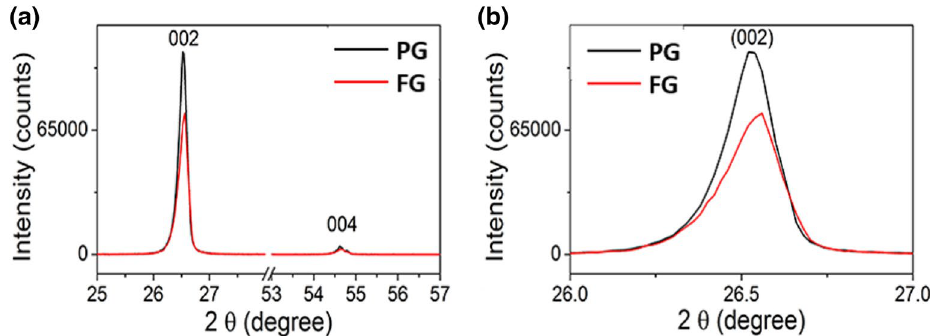
Figure 1. ( a ) XRD patterns of the PG and FG samples. ( b ) The enlarged (002) reflections used for the calculation of crystallite